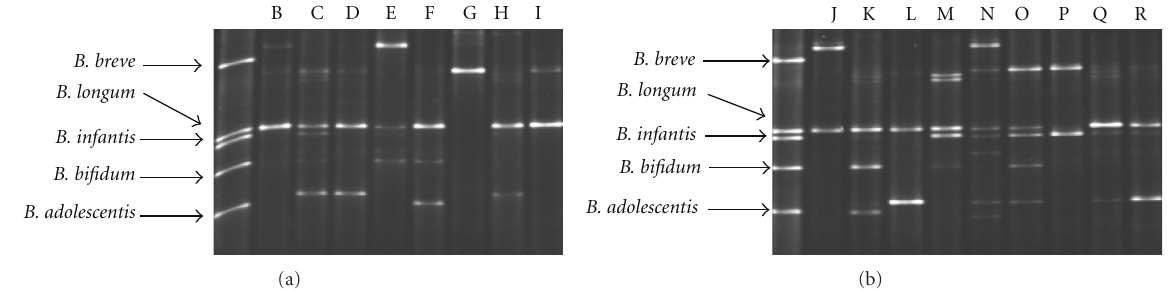
Figure 2: DGGE of bifidobacterial PCR-products (V3-region) from stool samples taken at eight weeks of age from infants treated with antibiotics B–I (a) and controls J–R (b). The mobility of the PCR products obtained in DGGE was compared to the PCR pattern of reference strains obtained with the same primer